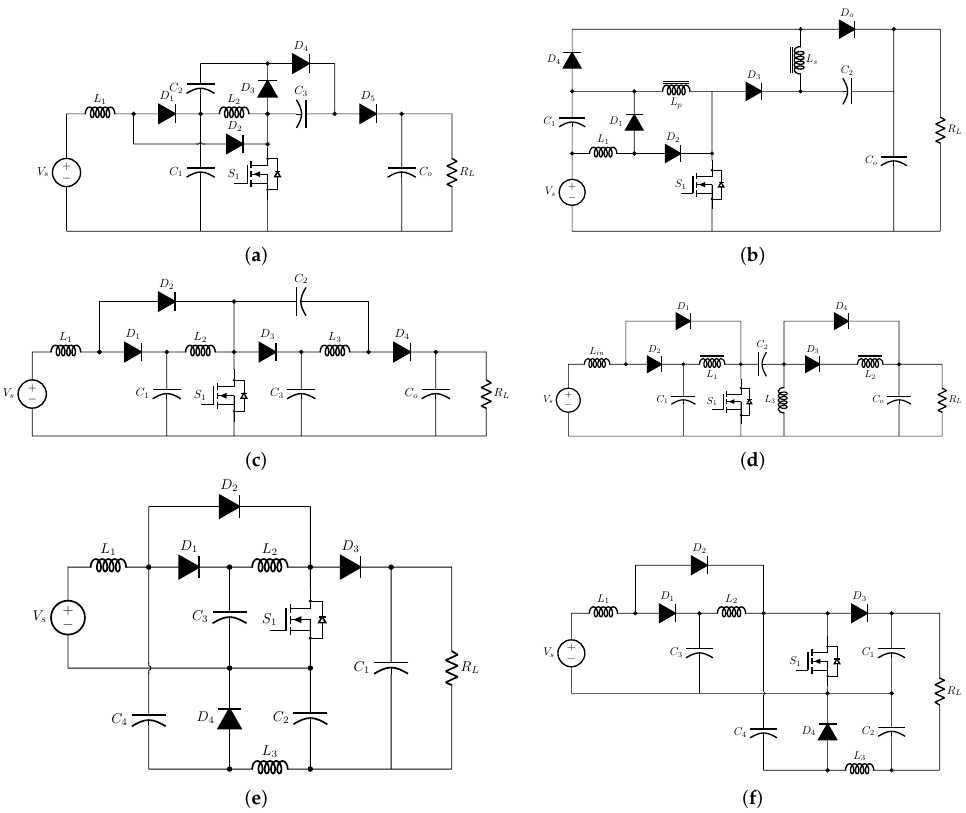
Figure 5. Cascaded Topology of Conventional Quadratic Boost Converter. ( a ) QBC based on VL, ( b ) QBC based on Coupled Inductor, ( c ) QBC and SEPIC Converters, ( d ) QBC-SEPIC based on SC and coupled Inductor, ( e ) QBC and ´Cuk Converter Type-I and ( f ) QBC and ´Cuk Converter Type-II. Table 2 summarises more details about quadratic boost converter in terms of compo- nent number, voltage gain, voltage stress on the main switch, voltage stress of output diode, input and output voltage, switching frequency and power rating, duty cycle, efficiency, feature of each DC/DC converter and